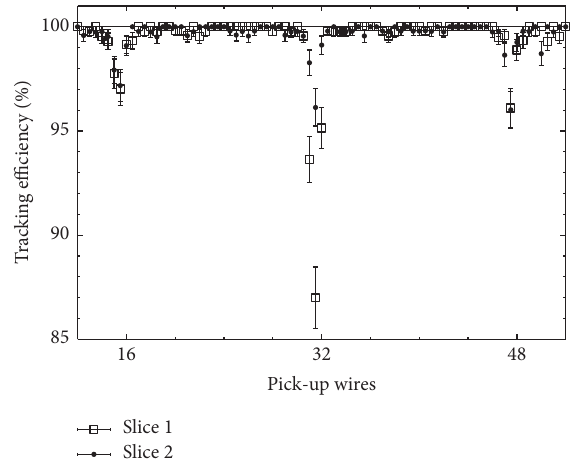
Figure 9: Efficiency drop around the support pillars averaged over the 3 cm wide slice indicated with the dashed lines in Figure